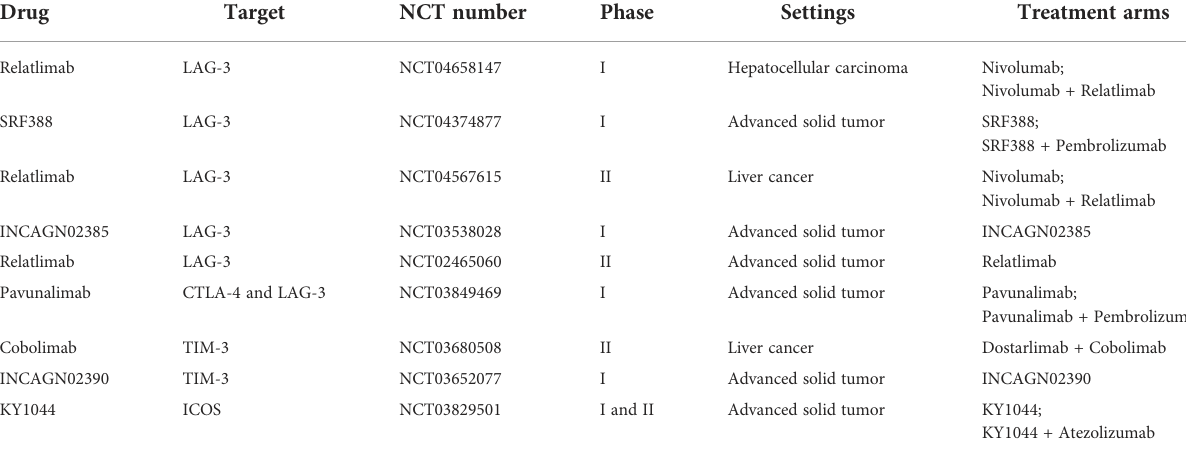
TABLE 2 Novel immune checkpoint inhibitors in